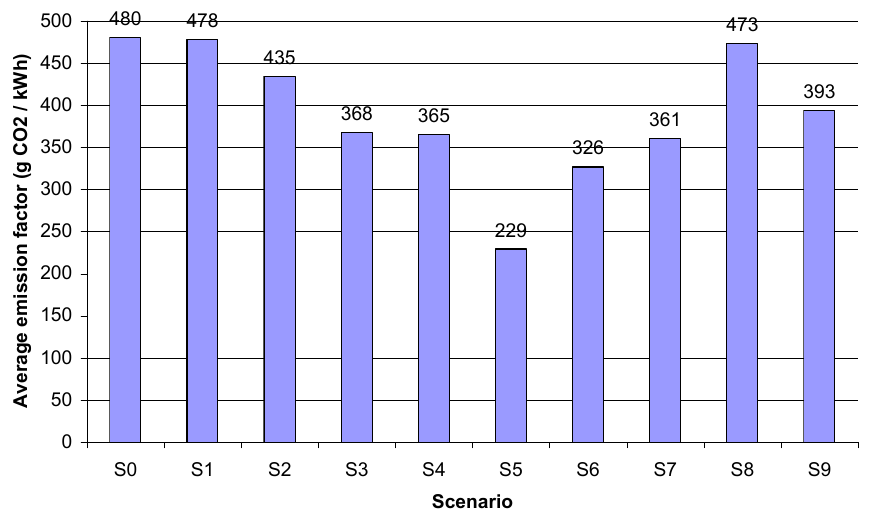
Figure 9. Average GHG emission factor for all scenarios.